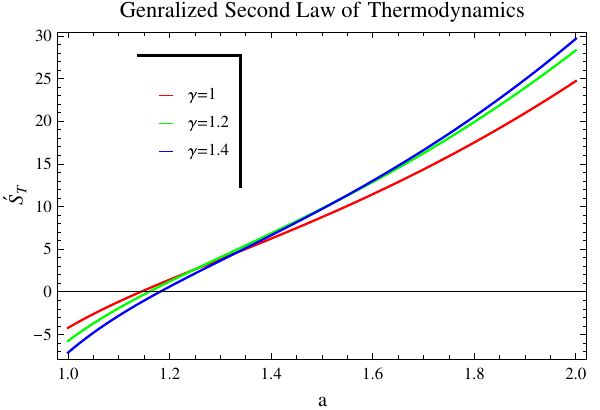
Fig. 4 Plot of ´ S T versus a for logarithmic corrected entropy using k = 1 , λ = − 1 , α = − 1 , L p = 1 , β = 1 and b = 1